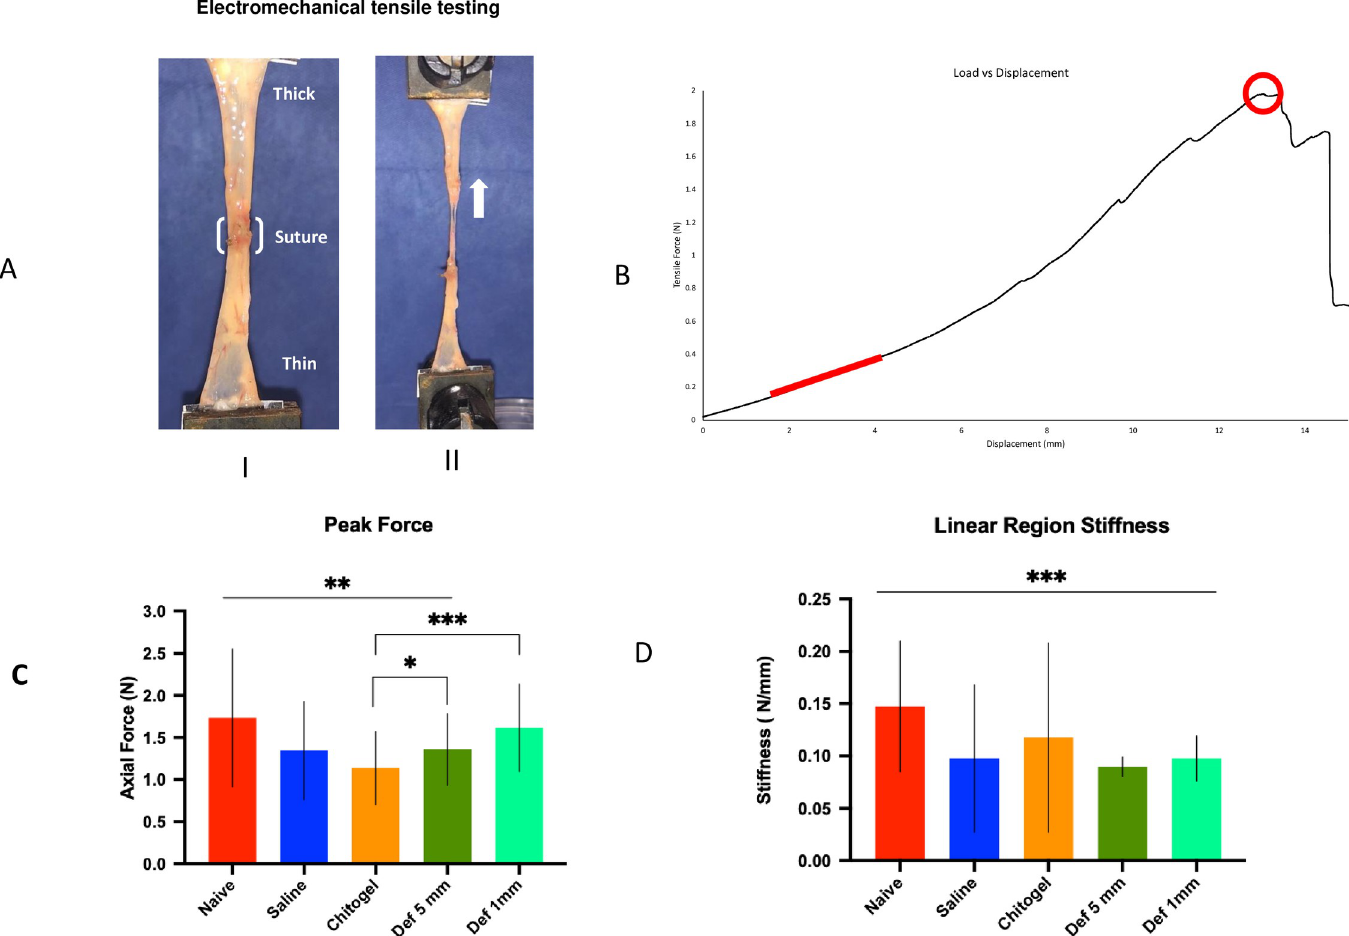
Fig 5. Electromechanical tensile strength testing. (A) Experimental set up showing specimen caecum split open and fixed to the Instron pneumatic arms with sutured area at its centre before being stretched (thick white arrow indicates direction of pull) for electromechanical tensile testing. (B) Load displacement graph showing value of tensile force [in Newton(N)] vs displacement [in millimetre(mm)]. The red line represents the linear region, from which the stiffness was calculated, and the red circle indicates the peak load location. (C) Bar graph of peak axial force [in Newton (N)] for the different treatment groups ��� p < 0.001, � p < 0.05, (D) Bar graph of Linear region stiffness [in Newton/mm (N/mm)] of caecum in different treatment groups specimens. ��� p < 0.001, compared to Na ï ve tissue.